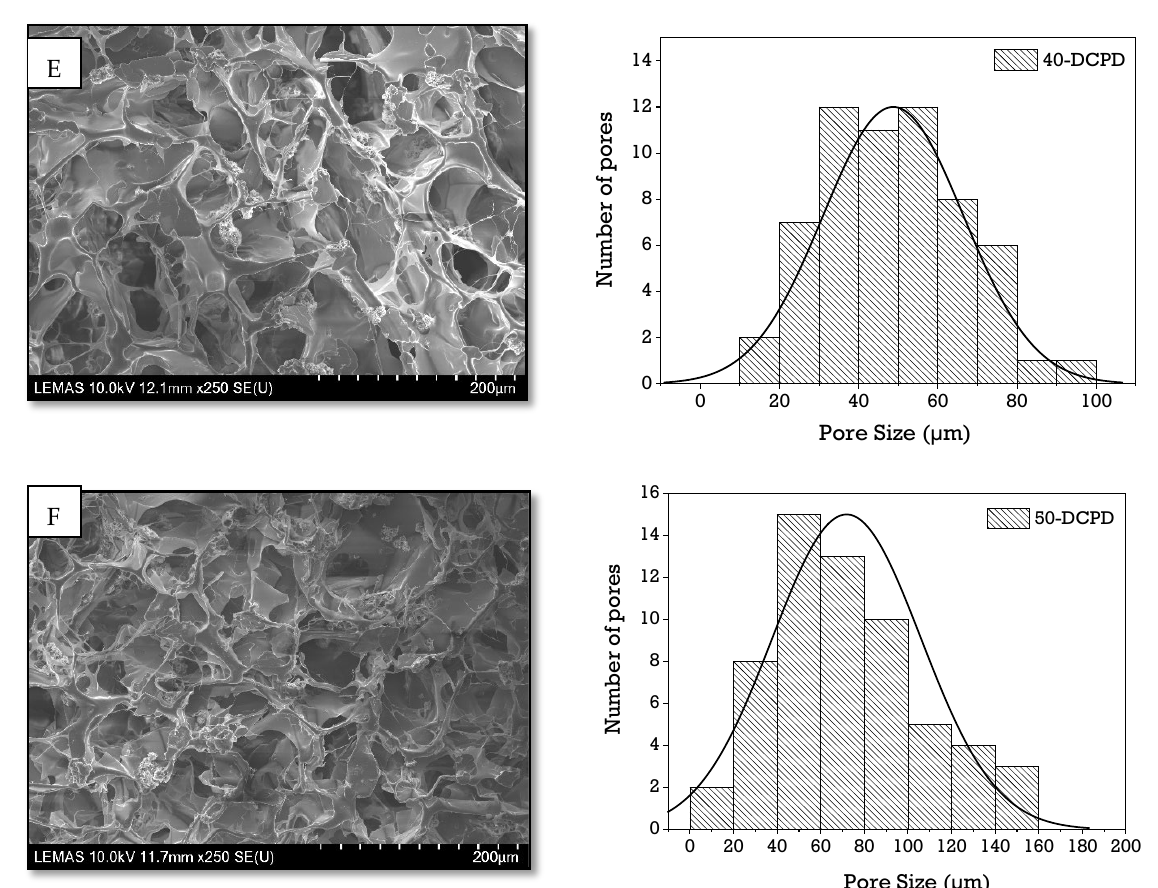
Figure 3. Comparison of Hitachi SU8230 SEM images of freeze-dried chitosan (CS) scaffolds con- taining Dicalcium Phosphate Dihydrate (DCPD) minerals ( A ) DCPD mineral, ( B ) CH, ( C ) 20-DCPD, ( D ) 30-DCPD, ( E ) 40-DCPD, and ( F ) 50-DCPD. The corresponding distribution graphs.